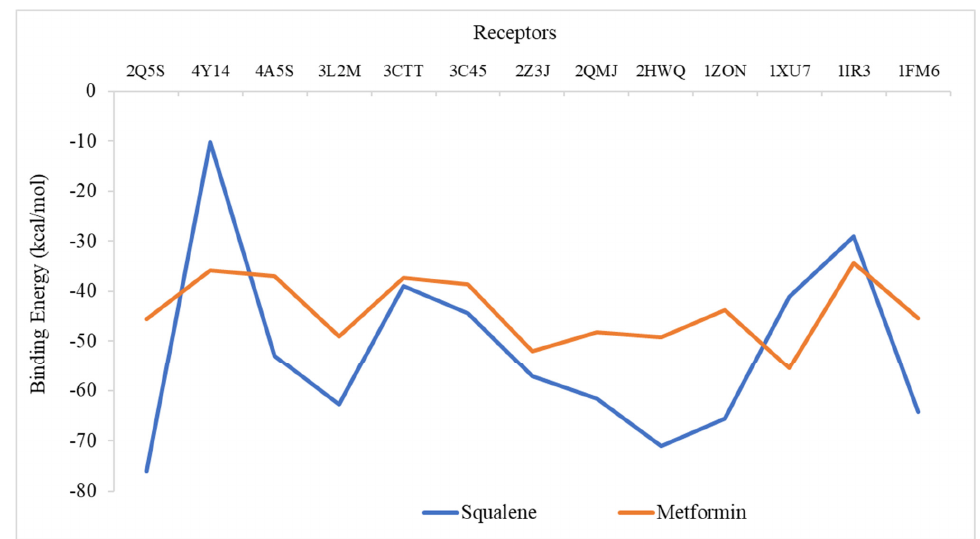
Figure 8. Binding energies of the ligands against thirteen protein receptors related to diabetes mellitus . 1FM9, heterodimer of the human RXR α and peroxisome proliferator–activated receptor